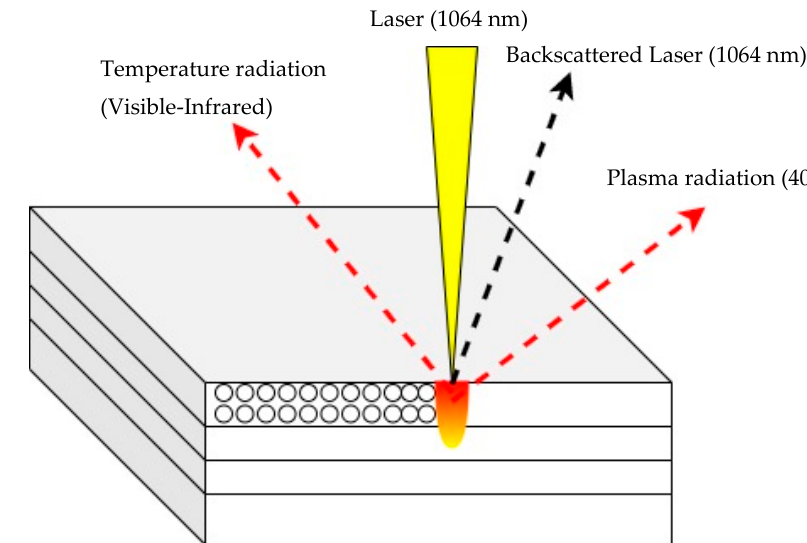
Figure 8. Illustration of types of emitting radiation from melt pool [58].